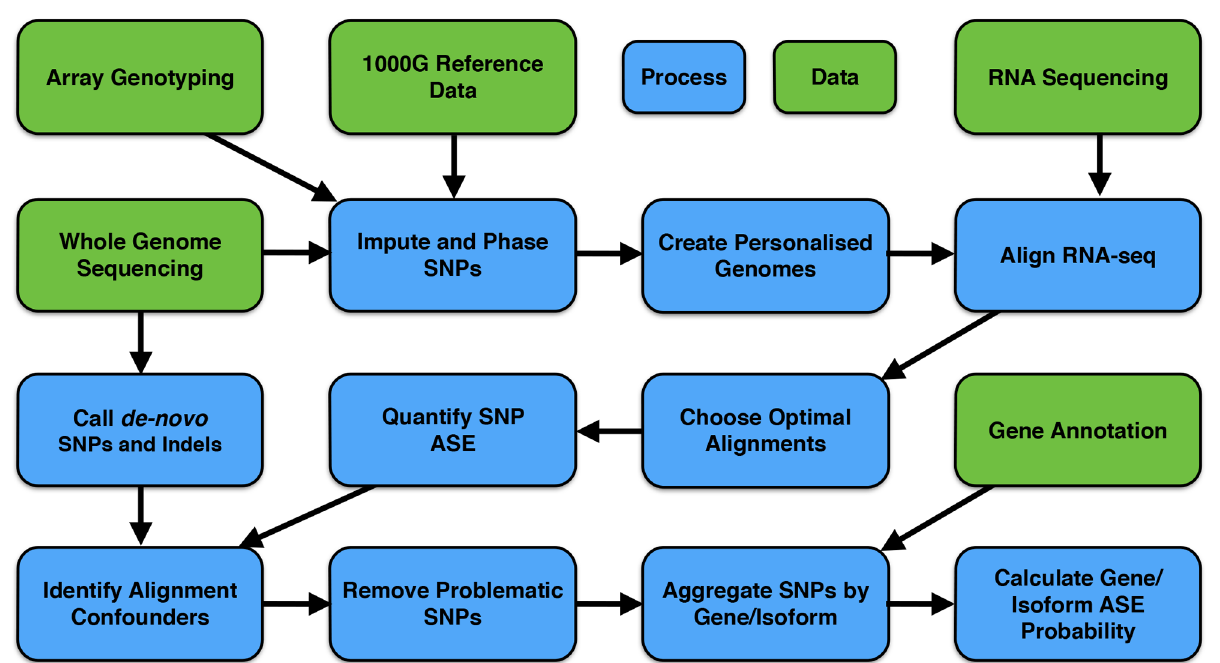
Fig 4. Recommended workflow for ASE quantification using matched genotype and RNA-seq data. Robust quantification of ASE requires detailed genotype information and matched high quality RNA-seq data. Phasing and imputing SNPs provides haplotype information, used to determine whether intragenic SNPs with imbalanced expression show concordant direction of imbalance, as well as build personalised reference genomes for alignment. Personalised alignment increases both sensitivity (data yield) and specificity of ASE quantification. WGS data can be used to identify indels and other proximal SNVs not included in the imputation reference data set that may confound alignment and potentially produce false positive ASE calls. SNPs proximal to such factors can be removed from further analysis. Aggregation of SNPs by gene and isoform boundaries reduces potential sampling issues for lowly expressed regions, and assists in identifying ASE regions (genes and